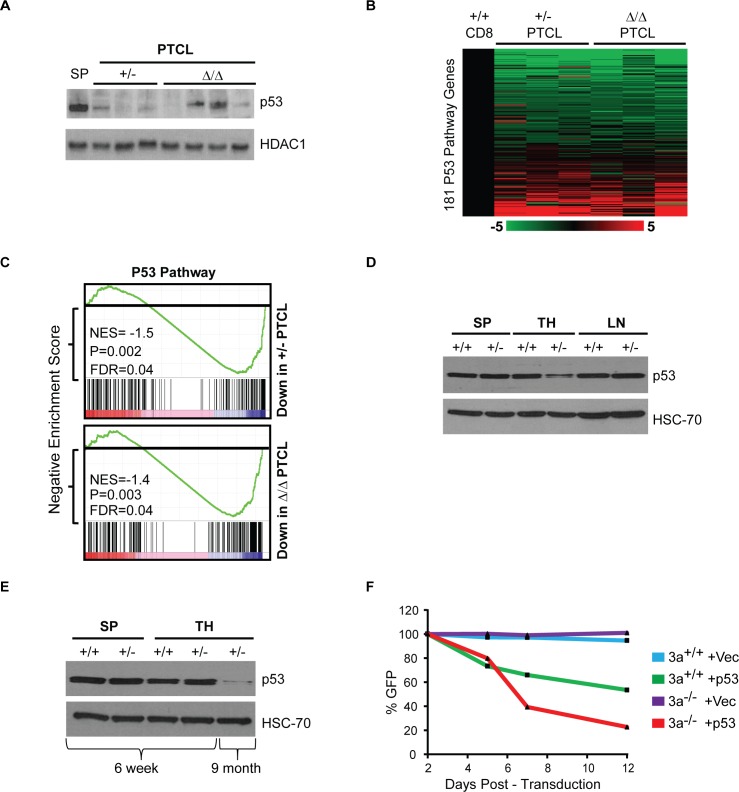
P53 is downregulated in pretumor thymocytes and in Dnmt3a+/- and Dnmt3aΔ/Δ PTCLs.(A) Immunoblot showing p53 protein levels in Dnmt3a+/+ control spleen (SP), Dnmt3a+/- PTCL (+/-) Dnmt3aΔ/Δ PTCL (Δ/Δ) samples. HDAC1 is shown as a loading control. (B) Heatmap showing fold change in gene expression data derived from RNA-seq of 181 p53 pathway genes identified through GSEA for Dnmt3a+/- PTCL and Dnmt3aΔ/Δ PTCL relative to CD8+ controls. (C) RNA-seq expression profiles on Dnmt3a+/- PTCL, and Dnmt3aΔ/Δ PTCL were subjected to GSEA to identify enriched signatures. Each group was run as a pairwise comparison to normal CD8+ cells. In both tumor groups, the p53 pathway was identified as being significantly downregulated relative to controls. Normalized enrichment scores (NES), false discovery rate (FDR) and P-values are shown for each analysis. Black bars indicate individual genes within the pathway. Red indicates genes with high expression and blue indicates low expression in tumors relative to controls. (D) Immunoblot showing p53 protein levels in Dnmt3a+/+ (+/+) and Dnmt3a+/- (+/-) cells isolated from the spleen (SP), thymus (TH), and lymph node (LN) of 9 month old mice with no signs of lymphoma development. HSC-70 is shown as a loading control. (E) Immunoblot showing p53 protein levels in Dnmt3a+/+ (+/+) and Dnmt3a+/- (+/-) cells isolated from the spleen (SP) and thymus (TH) of 6 week and 9 month old mice with no signs of lymphoma development. HSC-70 is shown as a loading control. (F) Relative percentage of EGFP positive cells as determined by FACS for Dnmt3a+/+ (+/+) and Dnmt3a-/- (-/-) lymphoma cell lines infected with either MSCV-IRES-EGFP (Vec) or MSCV-IRES-p53-EGFP (p53). EGFP measurements were taken at multiples time points and normalized by the percentage of EGFP positive cells observed 2 days post-transduction.